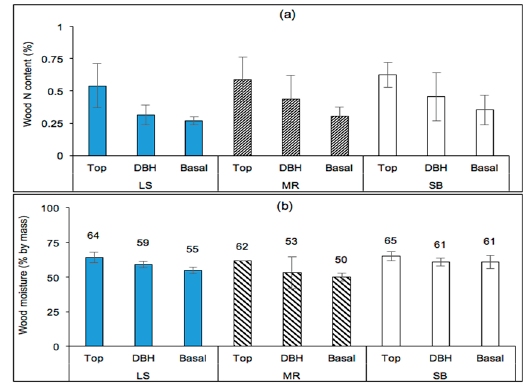
Figure 10. ( a ) Nitrogen content (N, %) and ( b ) moisture content by mass (%) of poplar wood at various tree positions for three clones (140, 187, and 188) sampled from stands located in the Piedmont (SB), the upper southern Blue Ridge Mountains (LS), and the lower southern Blue Ridge Mountains (MR).